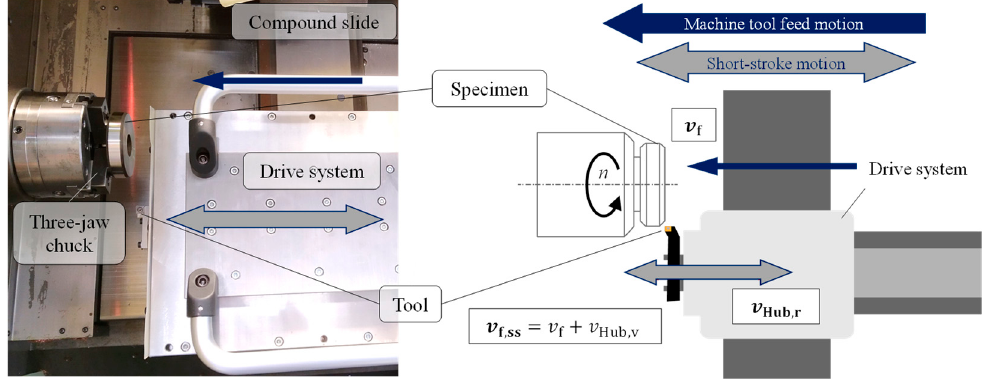
Figure 1. Experimental setup with air bearing drive system in SPINNER lathe ( left ) and the sche- matics of the motions during SST ( right